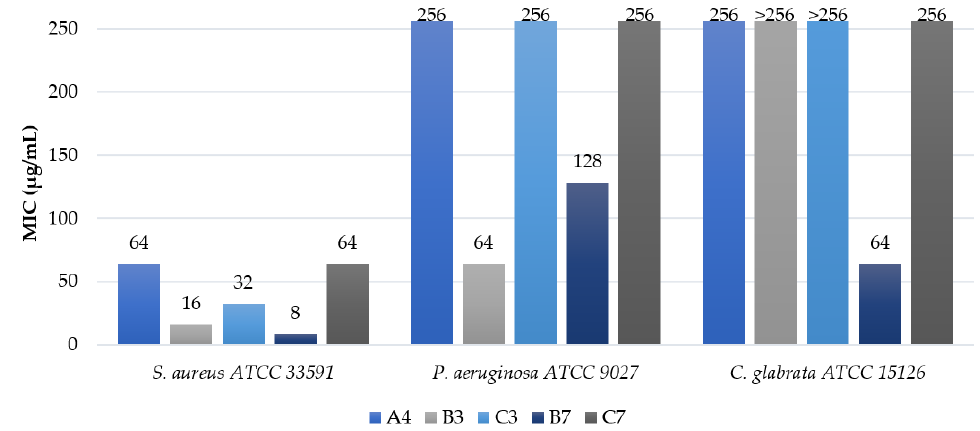
Figure 9. Minimum inhibitory concentrations (MICs) of selected compounds in the 10% ( v / v ) normal human serum.